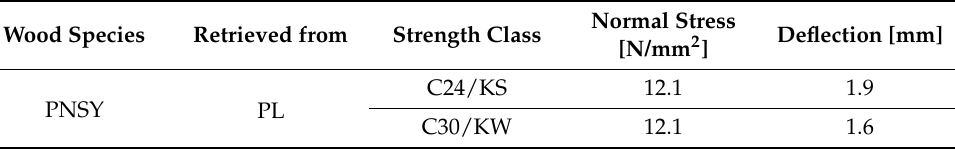
Table 14. Normal stresses and deflection (displacement) of D version short frames made of solid wood material (pine, country of origin: